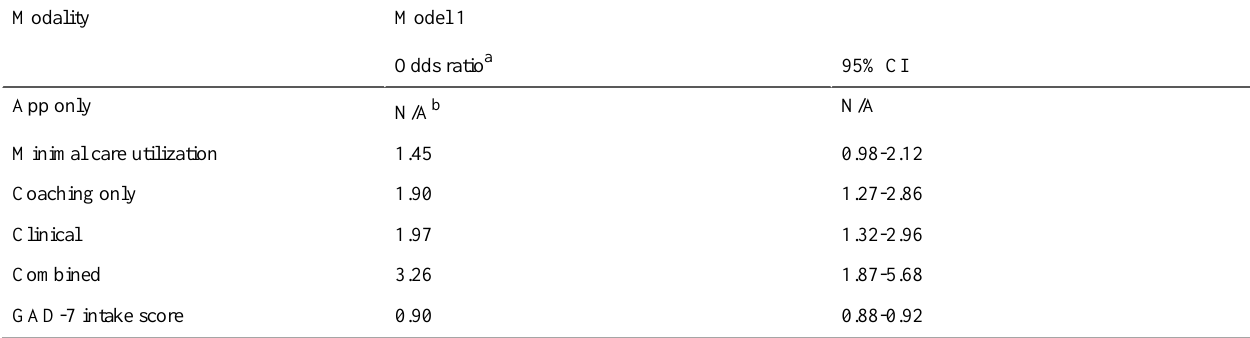
Figure 1. For all figures, shapes represent the expected mean probability of improvement by modality and intake severity; lines represent the corresponding 95% confidence